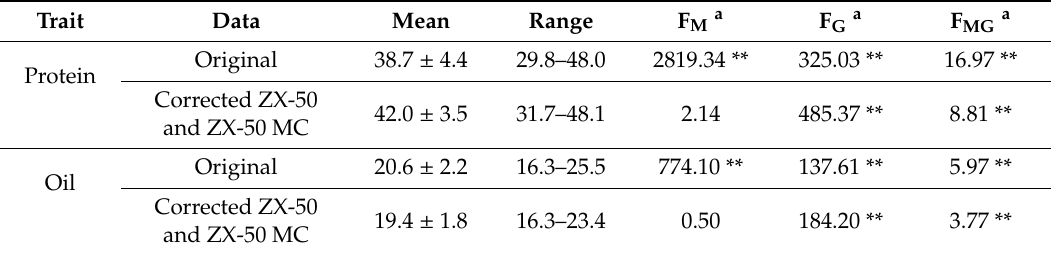
Table 1. Means, range of variation and F value in ANOVA of seed protein and oil content in 20 soybean entries analyzed by wet-chemistry and three NIR methods (DA 7250, ZX-50 and ZX-50 MC).